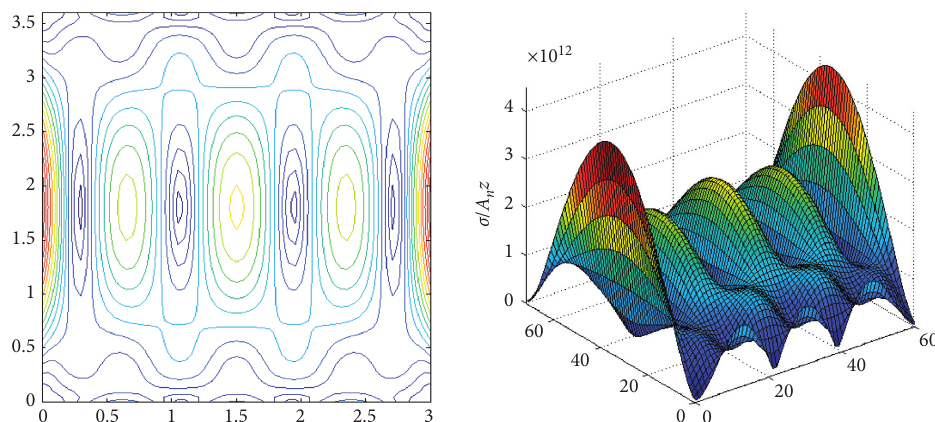
Figure 9: The maximum shear of the 6 th order mode (C-C-C-C).